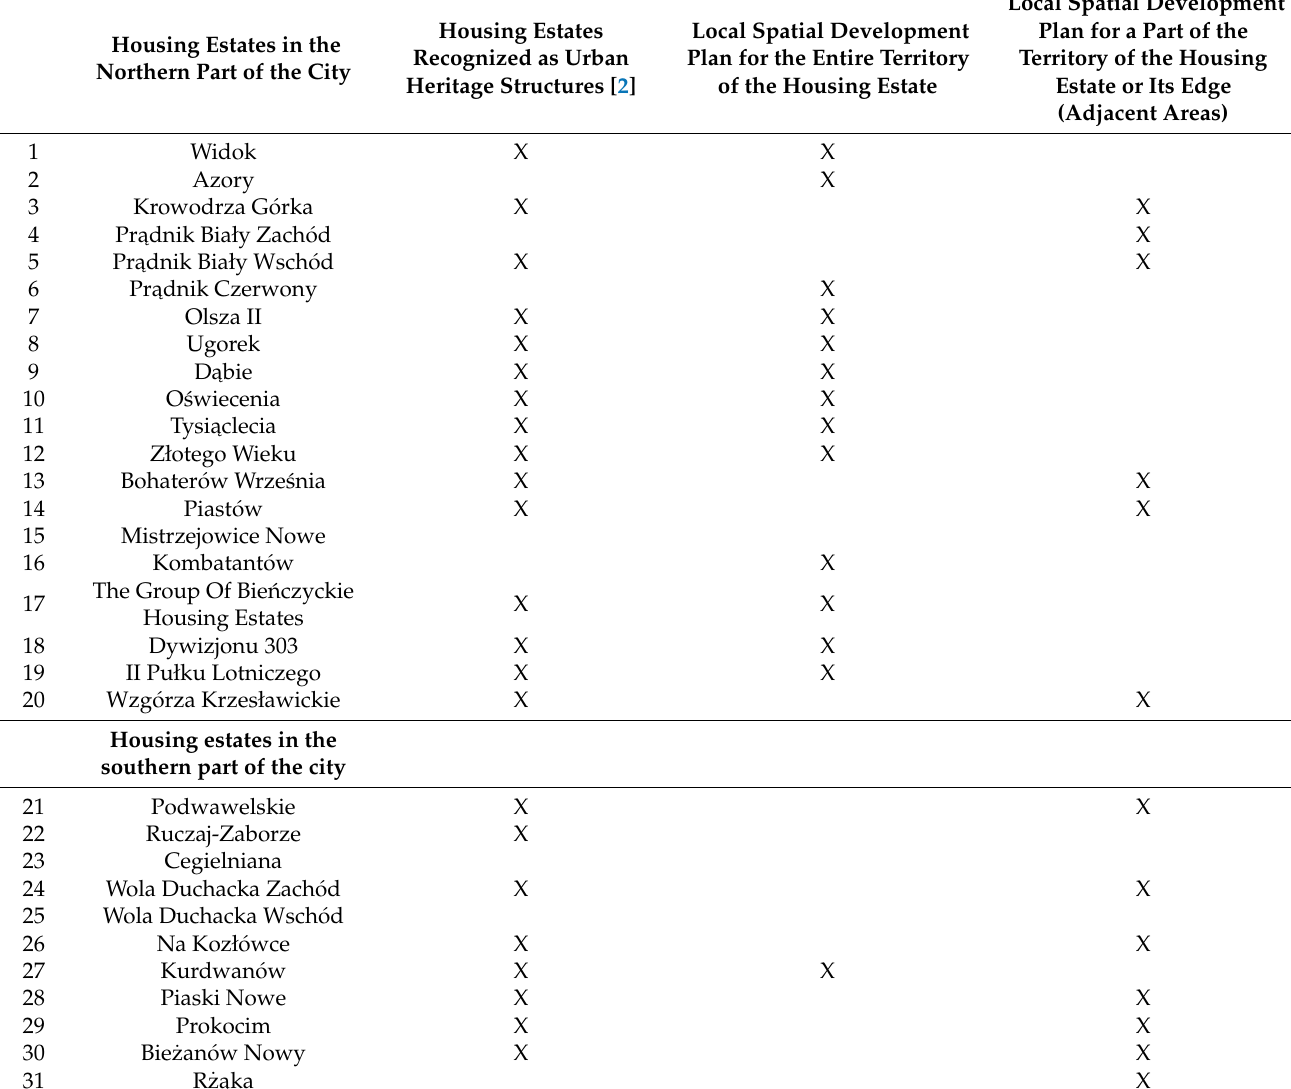
Table 2. List of housing estates recognized as urban heritage structures with their entire territories or parts thereof covered with local spatial development plans. Local Spatial Development Plan for a Part of the Local Spatial Development Housing Estates Housing Estates in the Territory of the Housing Plan for the Entire Territory Recognized as Urban Estate or Its Edge of the Housing Estate Heritage Structures [2] (Adjacent